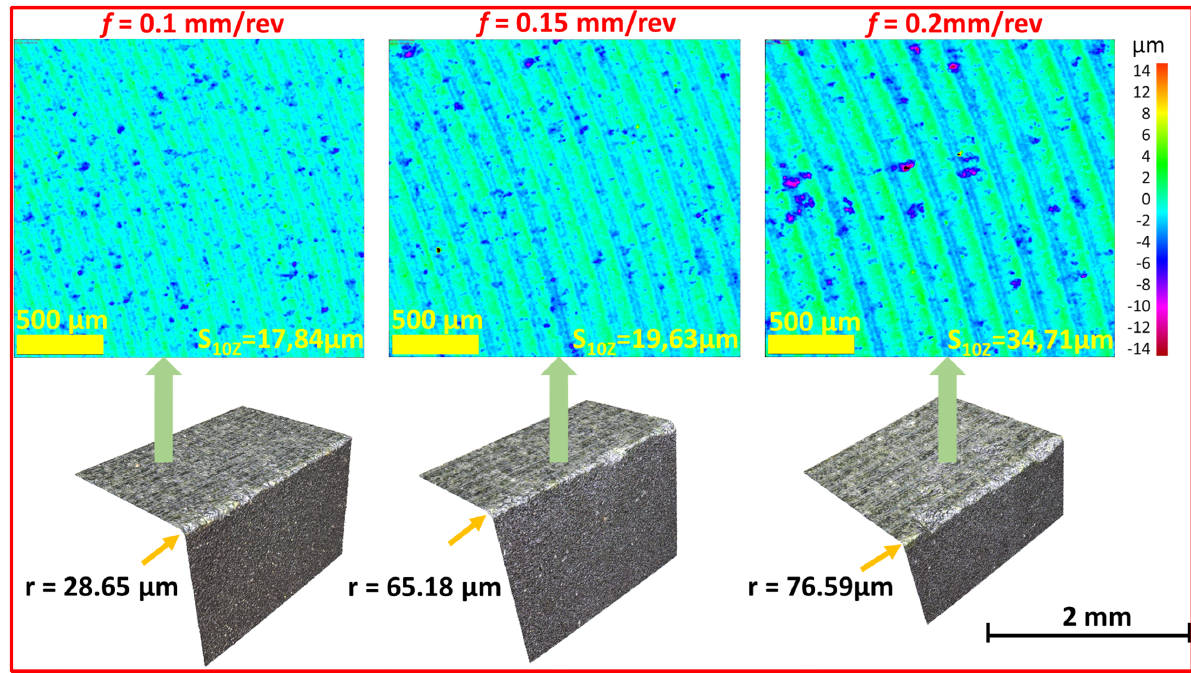
Figure 12. The surface roughness profile analyzed for the side 1 i.e., top part of the ceramic. The profile measurements were also evaluated by 2 × 2 mm area profilograms, as shown in Figure 13 for the top side. The edge roughness parameters such as R a (average roughness, integral of absolute roughness value), R q (Root Mean Squared roughness value), and R z (average peak to valley profile height) were also quantified to validate the turning optimization. The values for R a , R q and R z increased linearly with the feed rates from 0.1 mm/rev to 0.2 mm/rev which was in-line with the results obtained from surface roughness measurements in Figure 12. These profile roughness parameters were quite closely spaced for 0.1 and 0.15 mm/rev feed rates. The z-axis or height feedback in Figure 13 was slightly higher for the rapid feed rates. The profilograms shown in Figure 13 show the widening of the roughness profile for the feed rate 0.2 mm/rev, which implies that a higher degree of surface roughness is imparted if the duration of turning is reduced by one half. Thereby, for an optimal machining scenario and to retain machinability with a diamond PCD cutter up to 1000 passes, the feed rate can be reduced to 0.1 mm/rev.